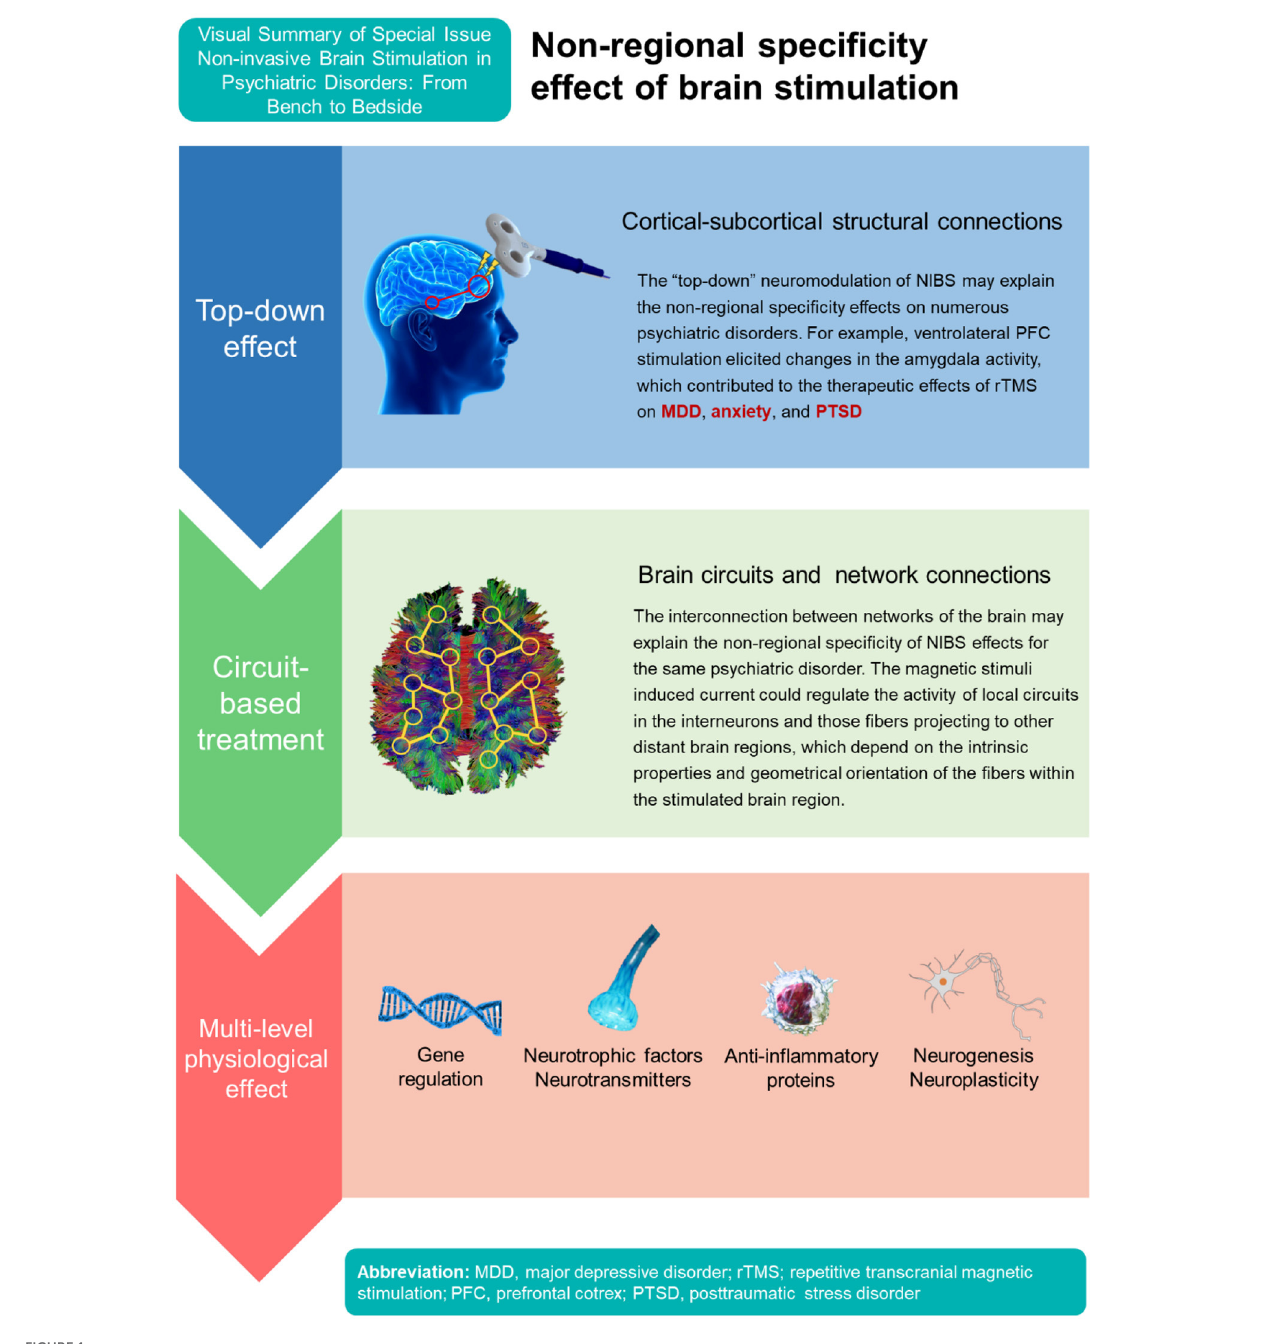
FIGURE1 Mechanisms of non-regional specificity effect of non-invasive brain